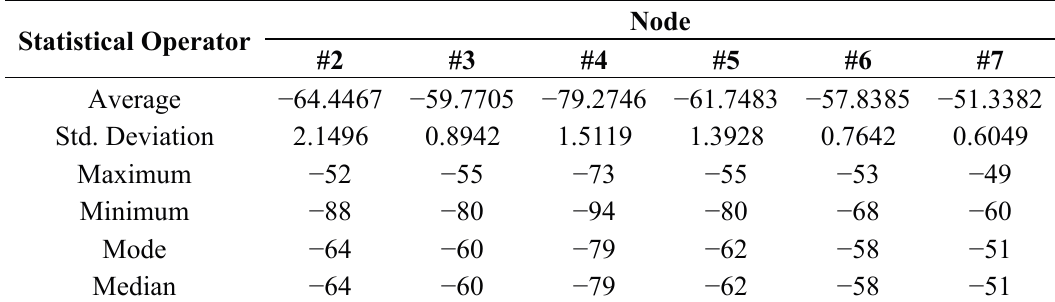
Table 3. RSSI statistics for the indoor